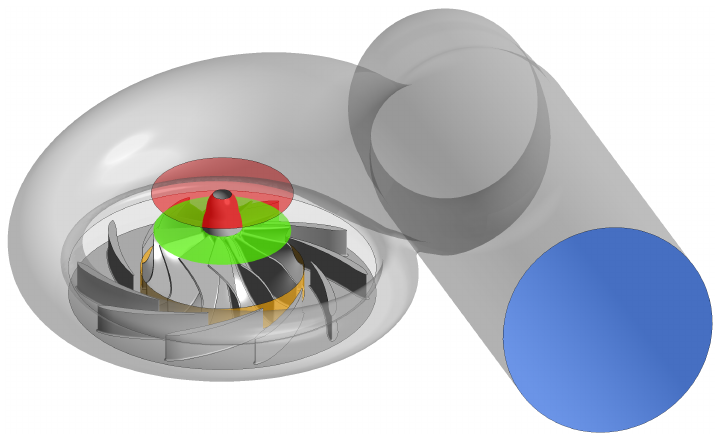
Figure 3. Full-annulus domain with inlet (blue), frozen rotor interface (orange), outlet (red), and analysis plane (green). Adapted from [12]. Copyright 2022